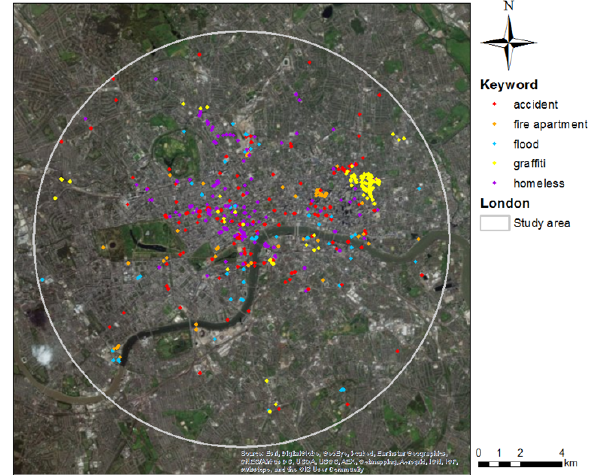
Figure 6. Position of the extracted posts for the London study area, coloured according to the keyword used in the search, and